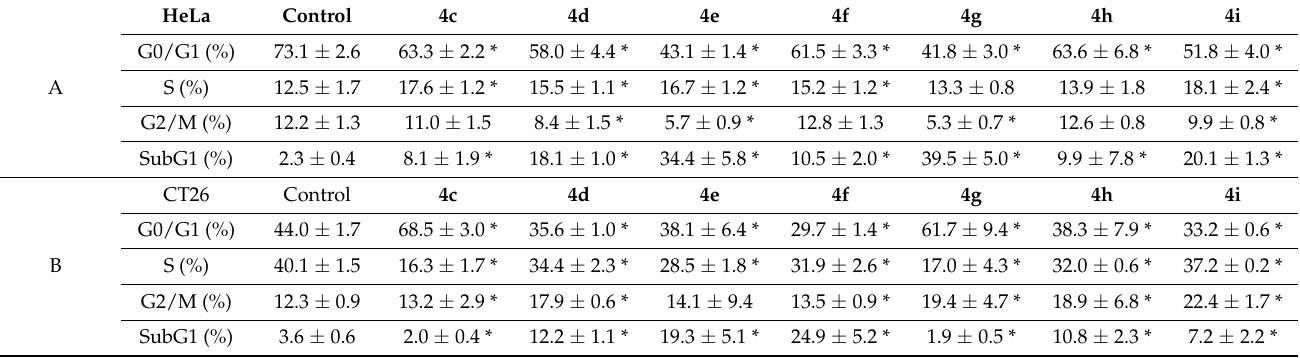
Figure 10. Effect of cycloadducts 4d , 4e , 4g , and 4h at concentrations 2, 5, and 10 μg/mL on the distribution of HeLa ( A ) and CT26 ( B ) cells in the cell cycle. Table 3. Effect of cycloadducts 4c – i at a concentration of 10 µ g/mL on the distribution of HeLa (A) and CT26 (B) cells during the cell